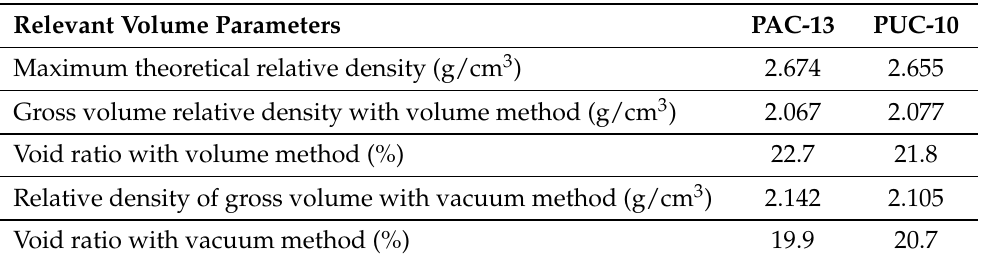
Table 2. Relevant volume parameters of asphalt mixture for PAC-13 and